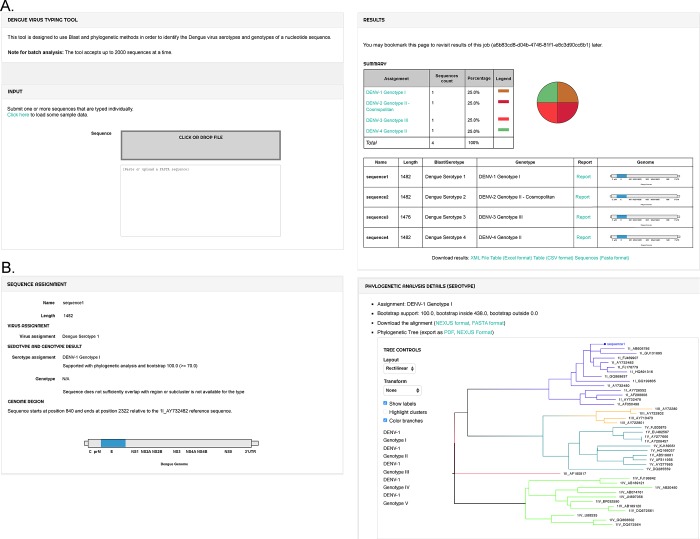
The typing tools’ web interface.The web interface provides users a portal to run classifications on their sequences and to visualize the classification results (A). The typing report presents information about the sequence name of the query sequence, the nucleotide length of the sequence, an illustration of the position of the sequence in the virus’ genome, the species assignment and the genotype assignment. A detailed report is provided for the phylogenetic analysis that resulted into this classification. All results can be exported to a variety of file formats (XML, CSV, Excel or FASTA format). The detailed HTML report (B) contains information on the sequence name, length, assigned virus and genotype, an illustration of the position of the sequence in the virus’ genome and the phylogenetic analysis section. The phylogenetic analysis section shows the alignment and constructed phylogeny: the query sequence is always shown at the top of the phylogenetic tree.